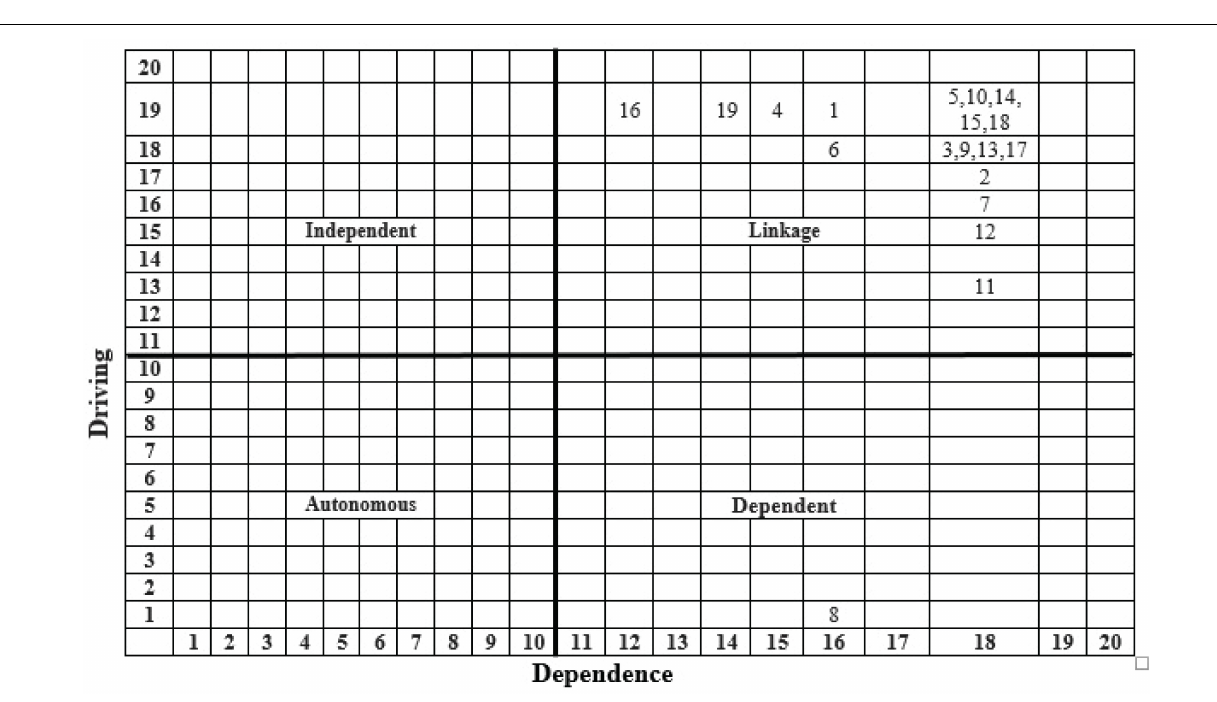
FIGURE 1 | Interpretive structural model.